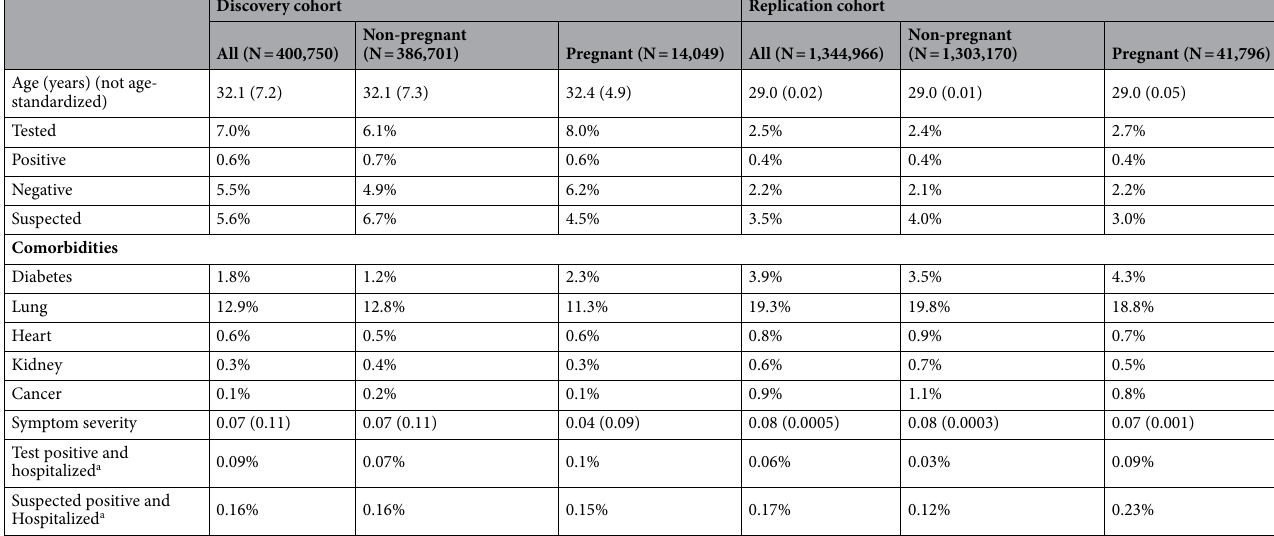
Table 1. Characteristics of the two cohorts, presented as percentages and means (standard deviations) in the cohorts. Except for group age, percentages and means are age standardized to the pregnant population age distribution in each cohort. Adjustment for survey weights was applied to the replication cohort. Self-report of being seen at a hospital was used as a proxy for hospitalization in the replication cohort. a Hospitalization not queried in replication cohort. Proportion of who tested positive or were suspected positive and who reported seeking care at a hospital for symptoms in the prior 24 h provided as a proxy.